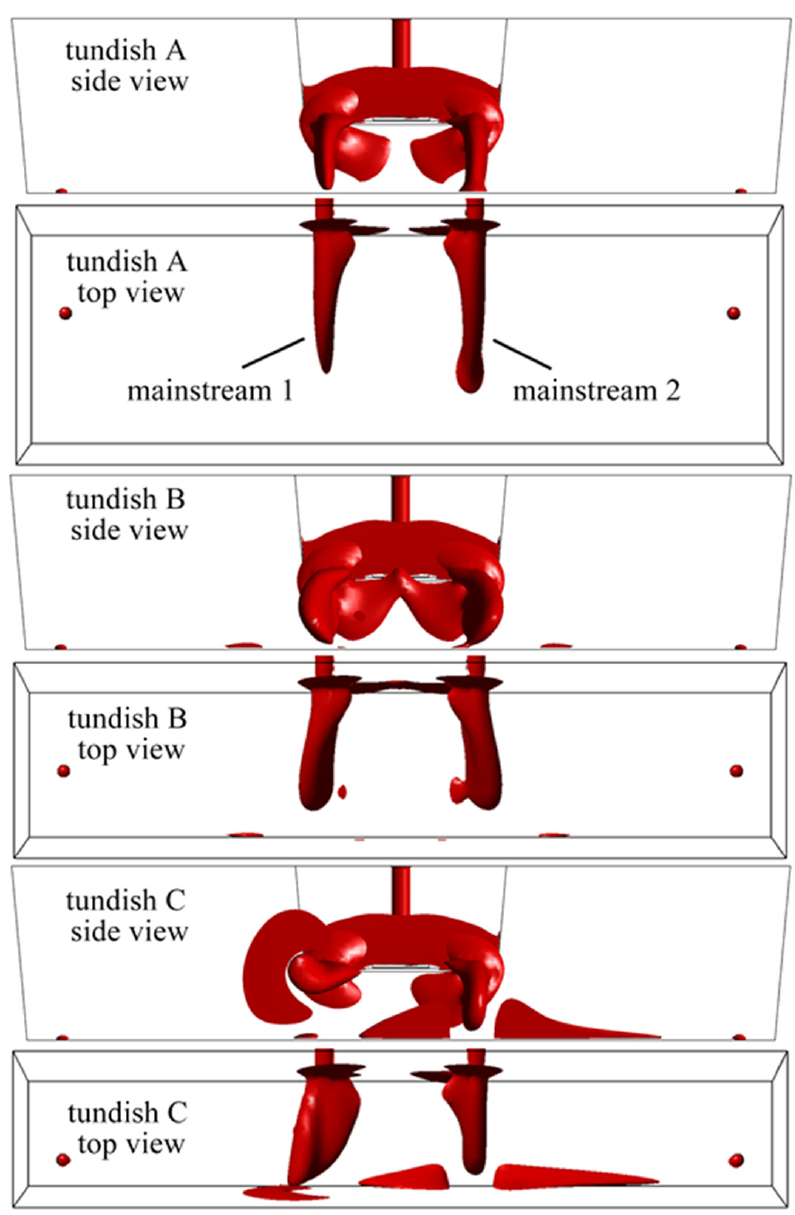
Figure 8. Mainstreams in the distributing chambers.